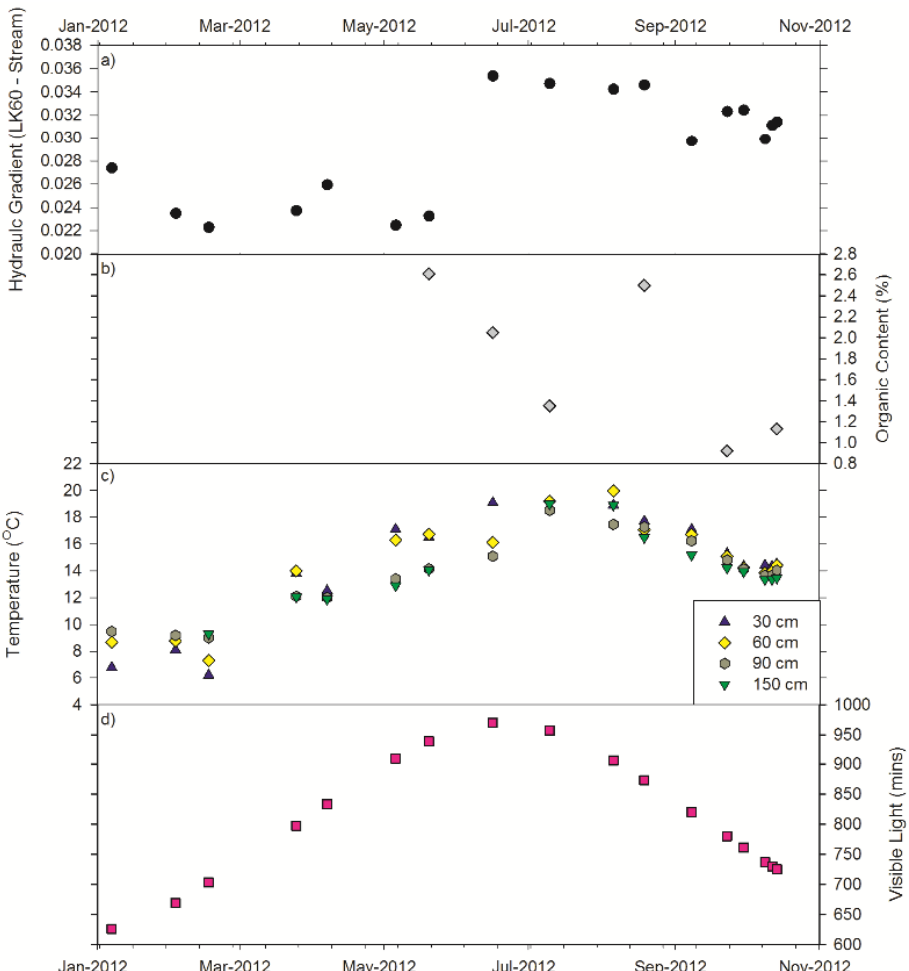
Figure 4. ( a ) Hydraulic gradient between LK 60 and the stream; ( b ) organic content within the top 25 cm of the streambed; ( c ) temperature measured within the hyporheic zone at the specified depth; ( d ) visible light measured during the day.